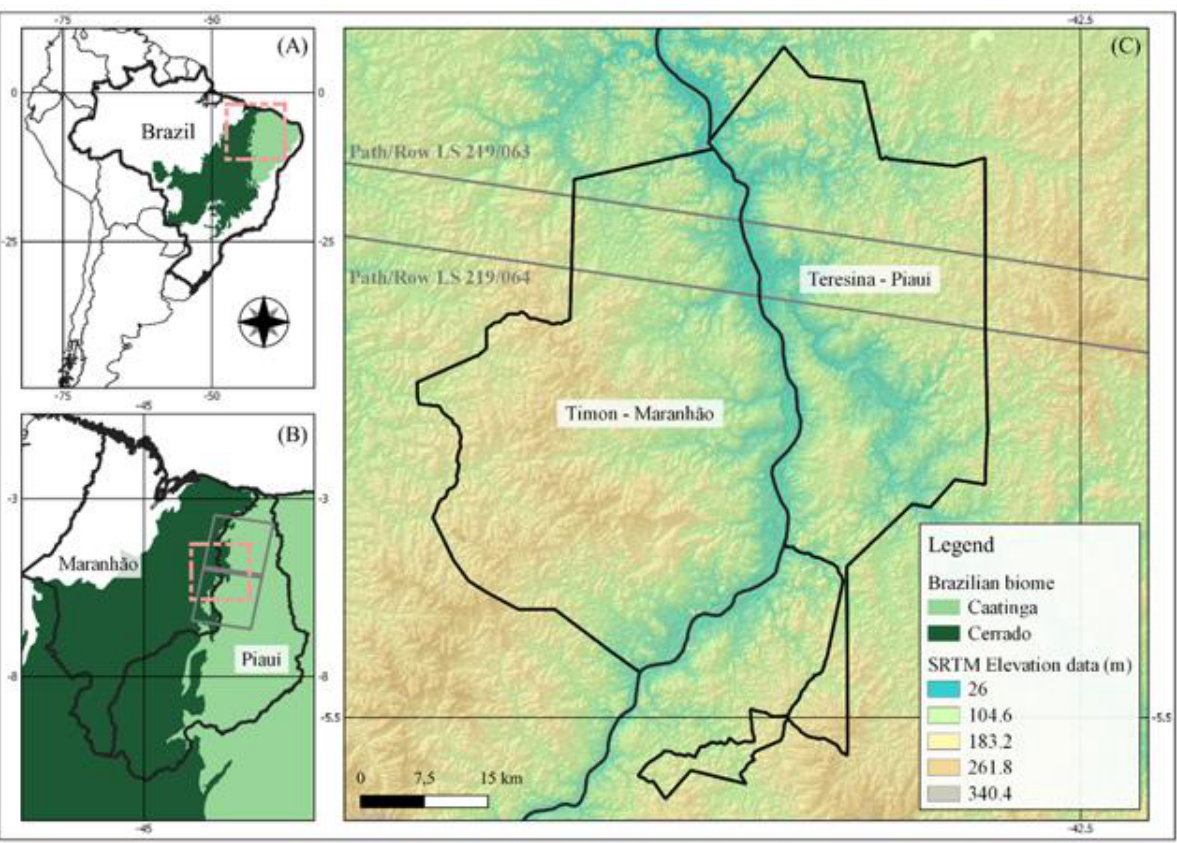
Figure 1. Location of the study area: ( A ) Cerrado and Caatinga biomes in Brazil; ( B ) Maranhão (MA) and Piauí (PI) Brazilian states, and the location of Landsat (LS) scenes of path/row 219/063 (north) and 219/063 (south); ( C ) Timon-MA and Teresina-PI municipalities, and the Shuttle Radar Topography Mission (SRTM) elevation map.